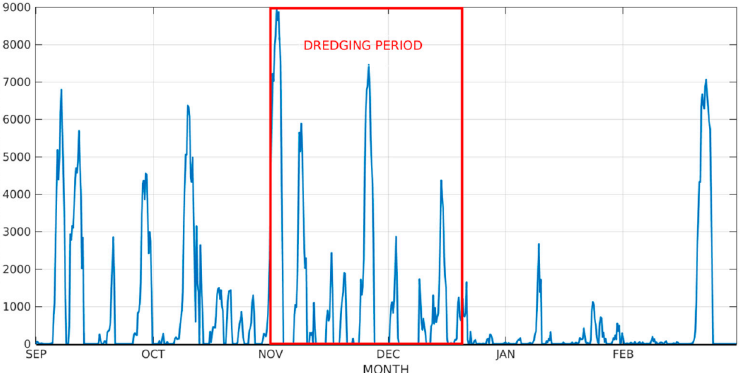
Figure 4. Time series of suspended sediment flux at the mouth of Patos Lagoon towards the coastal zone during the simulated period. The red rectangle represents the suspended sediment flux during the dredging